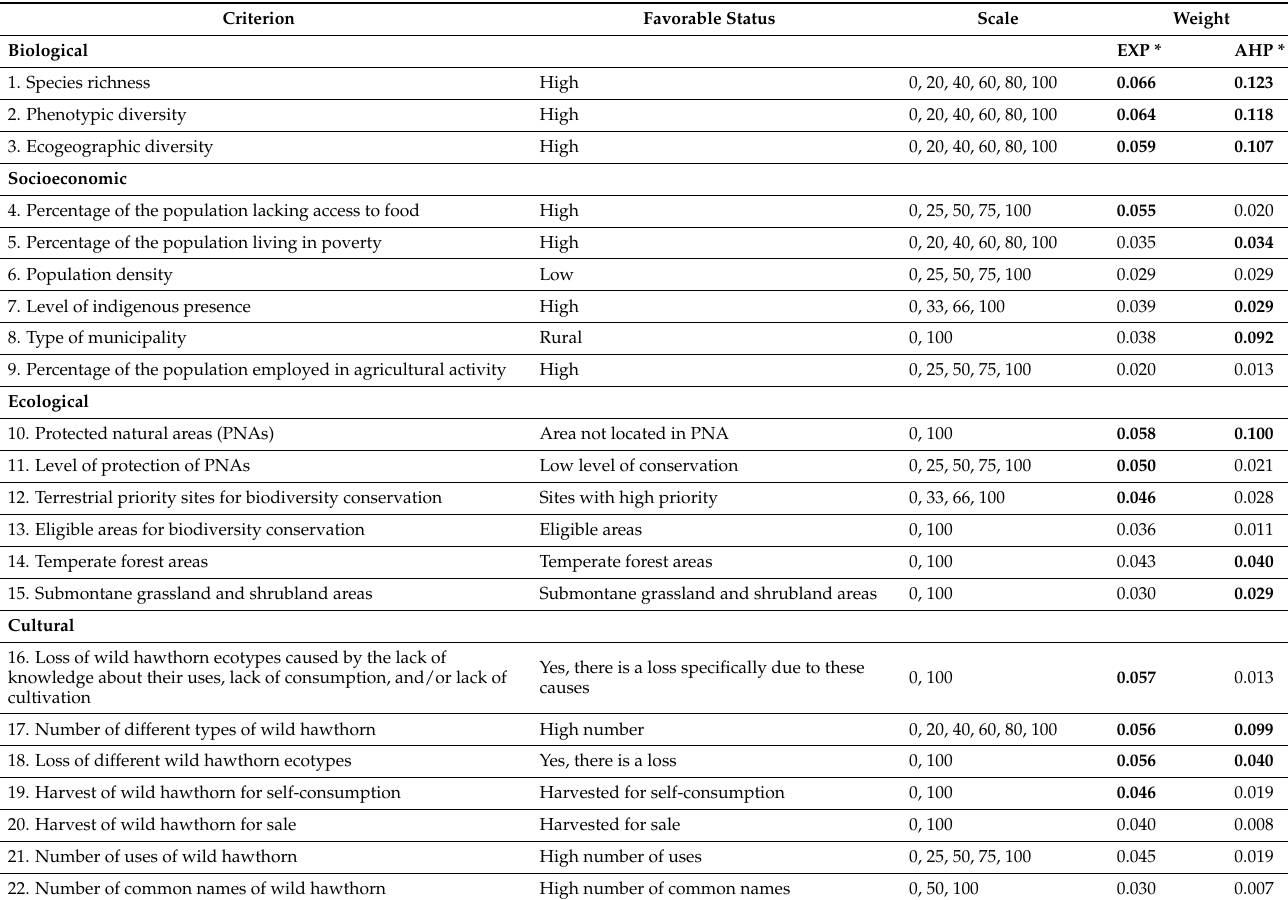
Table 1. Favorable status, final values, and weight of the important criteria in the identification of priority areas for the in situ conservation of wild hawthorn ( Crataegus spp.) species, obtained by experts (EXP) and analytic hierarchy process